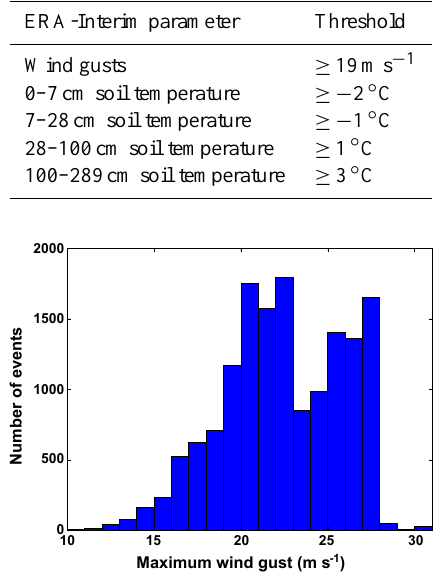
Figure 1. Histogram of the ERA-Interim maximum simulated wind gusts leading to observed forest damage.